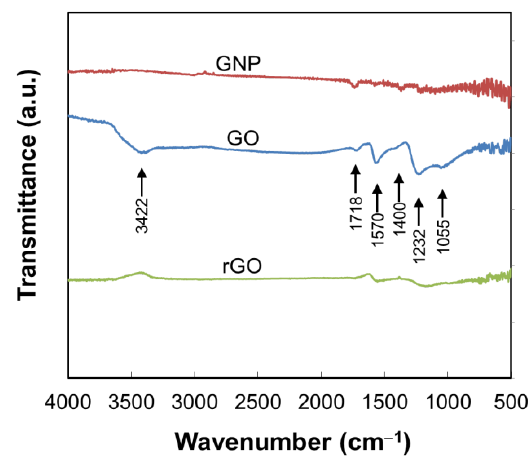
Figure 3. FTIR spectra of GNP, GO, and rGO samples.